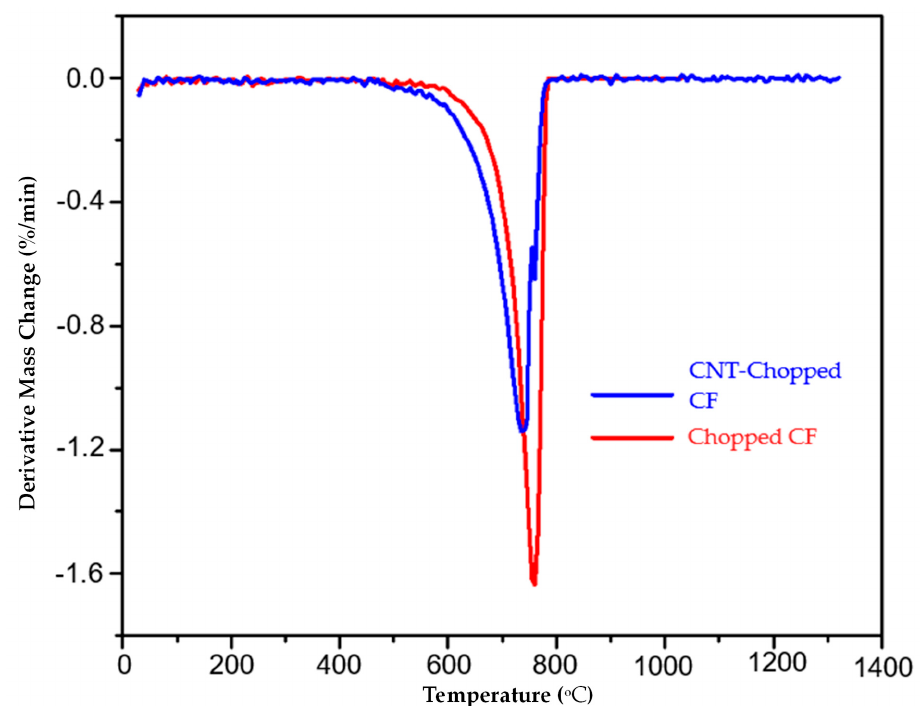
Figure 19. The first derivative of the TG graph for chopped carbon fiber and CNT-integrated chopped fiber. chopped